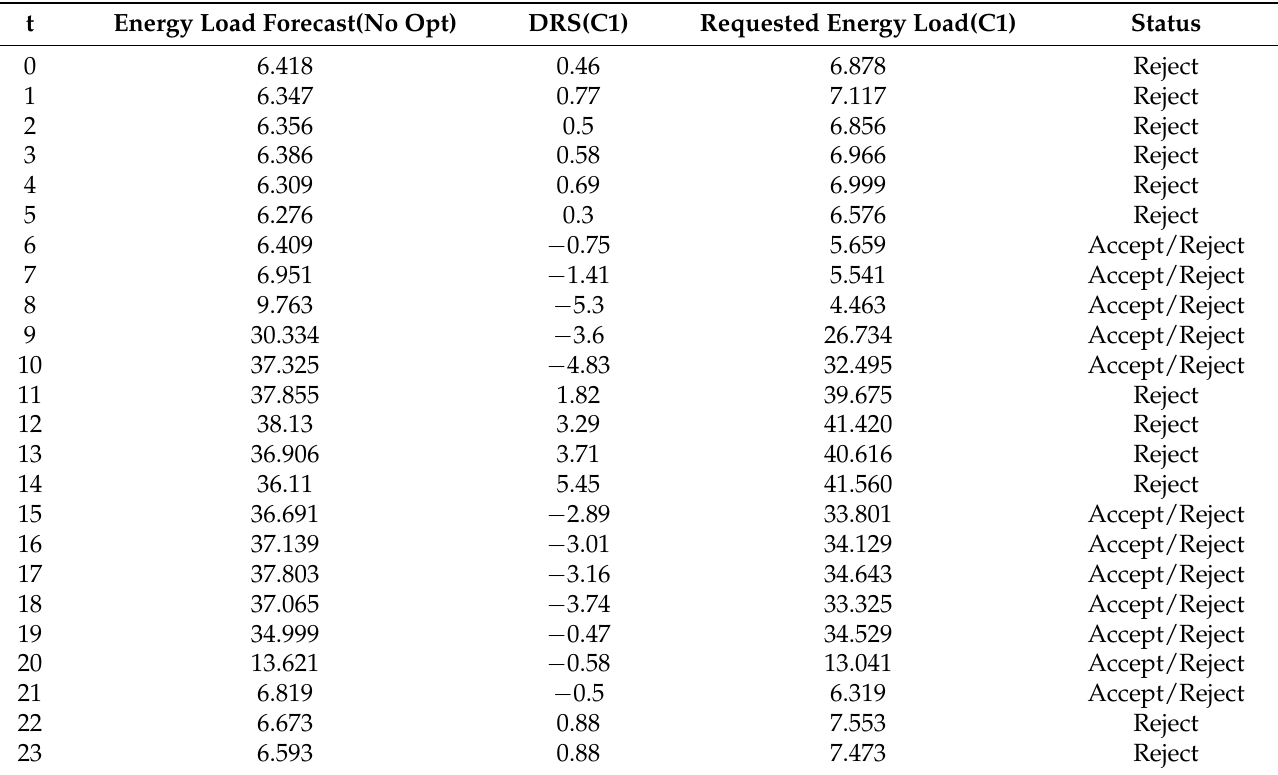
Table 3. Envisioned DR scheme and interaction between consumer and aggregator. No optimization for consumer.